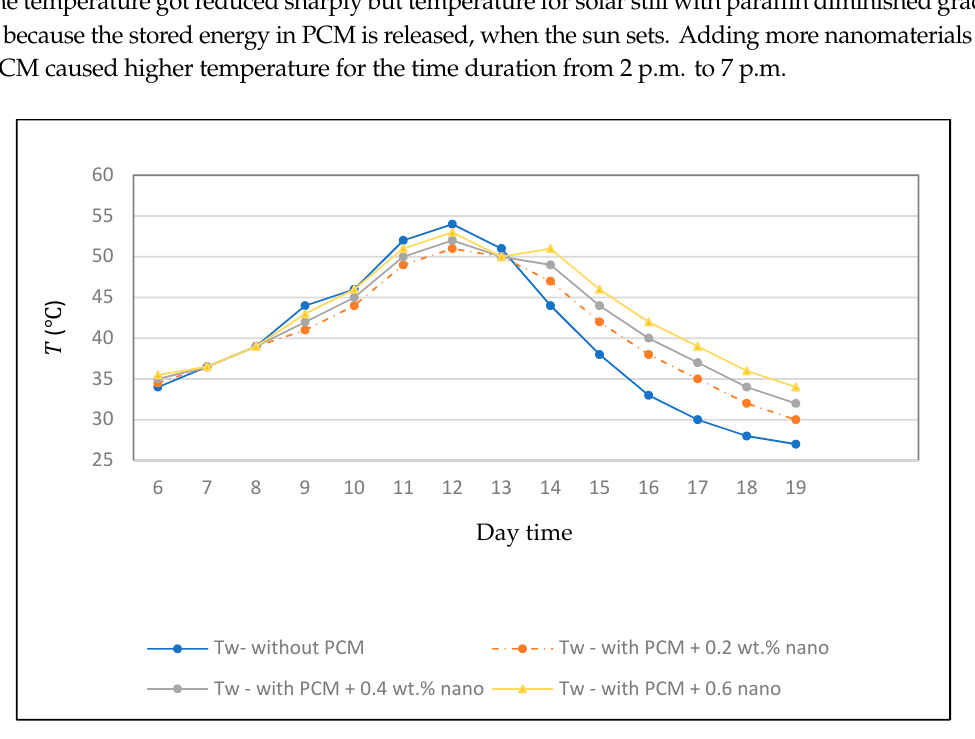
Figure 6. Comparison between temperatures in the presence and absence of PCM and nano-PCMs.